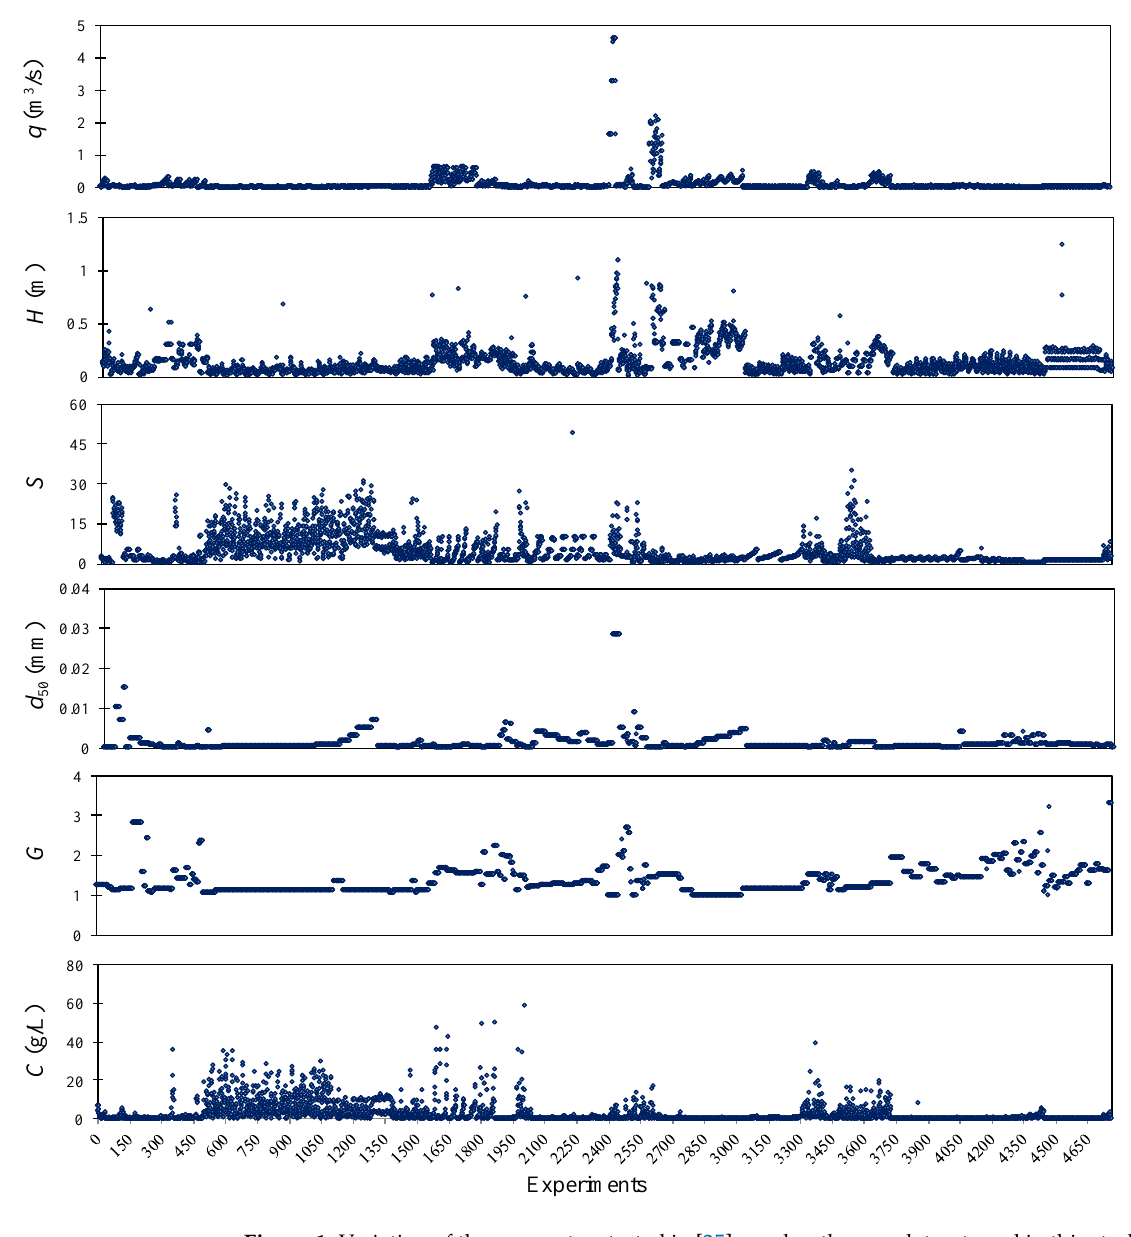
Figure 1. Variation of the parameters tested in [25], used as the raw dataset used in this study. q : river flow rate; H : flow depth; S : river longitudinal slope; d 50 : average particle diameter by mass; and G : specific density of sediment particles.